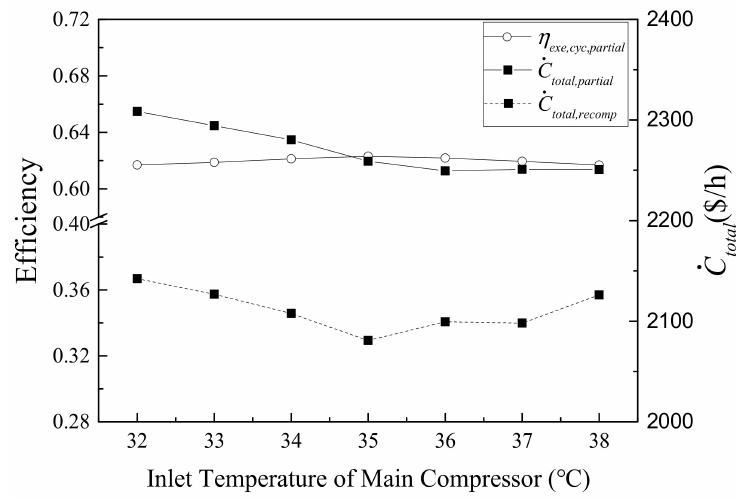
. C total with the partial-cooling cycle compared with the recompression cycle. Figure 13. Effects of T min on